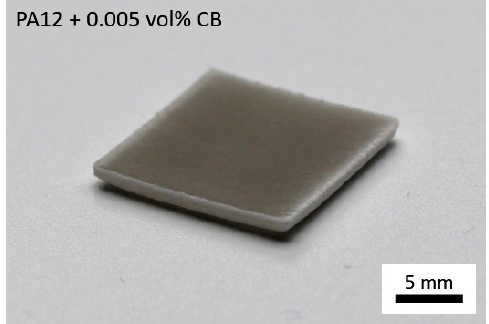
Figure 12. Test sample generated by PBF-LB/P of PA12 powder additivated with 0.005 vol% carbon nanoparticles.